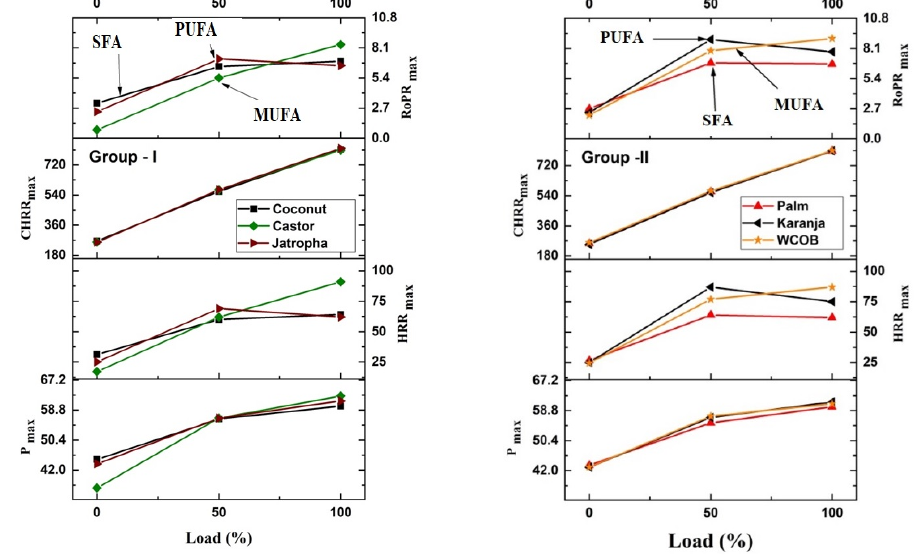
Figure 5. Variation in peak in-cylinder pressure (bar), HRRmax (kJ/m 3 ), CHHR ((kJ/m 3 ), and RoPR (bar) at 0%, 50%, and 100% loads.